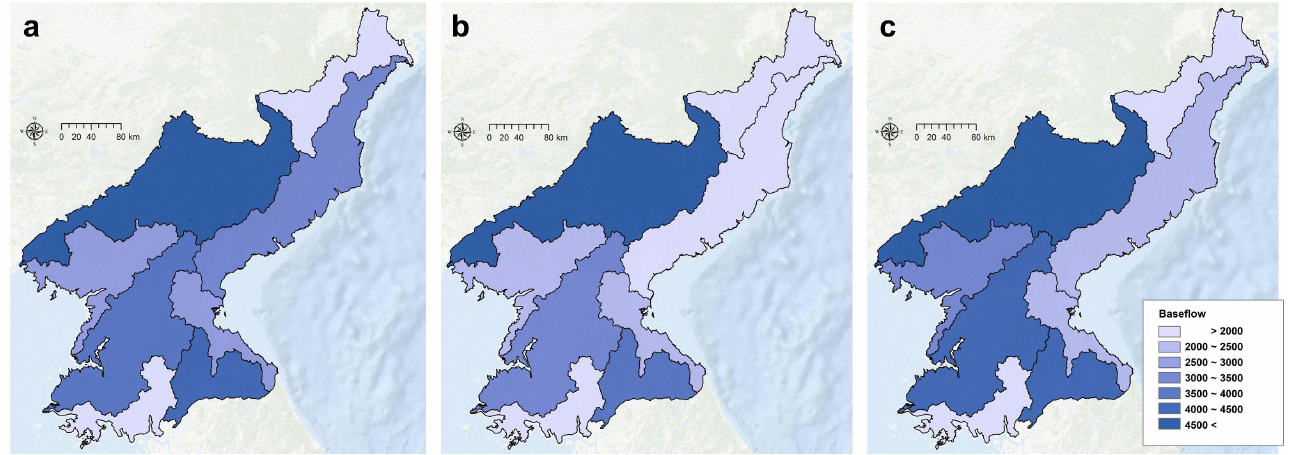
Figure 7. Baseflow amount at the main watershed level: ( a ) baseline period (1981–2010), ( b ) climate change (2041–2070), and ( c ) climate and afforestation scenario (Level 3, 2041–2070). Table 3. Local recharge and baseflow statistics of baseline period and future projection at the main watershed level (million m 3 y −1 ).